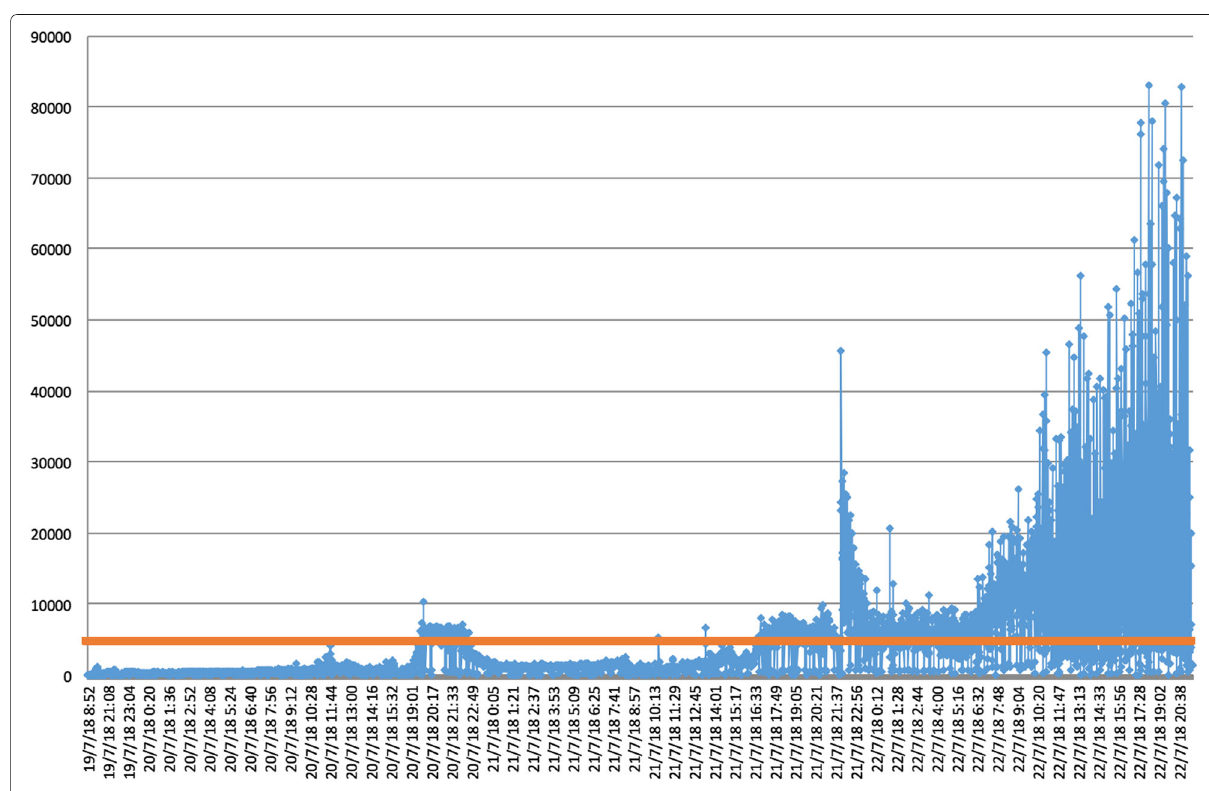
Fig. 5 Measurements received per minute. Total measurements in the period July 19-22,